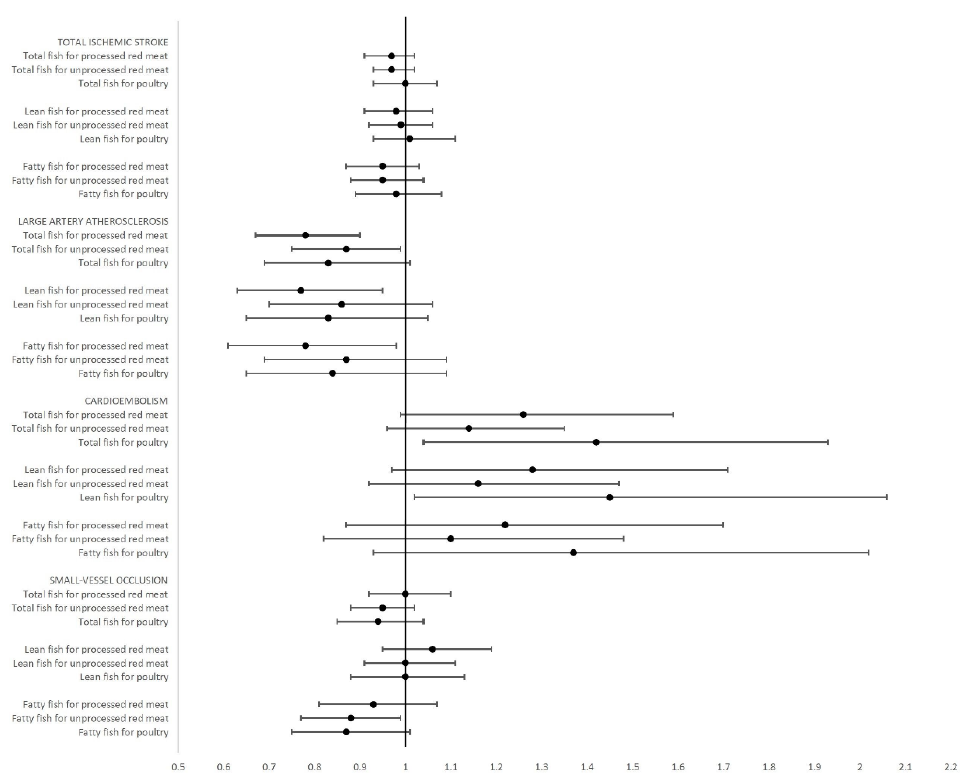
Figure 1. Hazard ratios and 95% confidence intervals for total ischemic stroke, large artery atherosclerosis, cardioembolism, and small-vessel occlusion when substituting total, lean, or fatty fish for processed and unprocessed red meat or poultry. Adjusted for age, sex, energy intake, length of schooling, physical activity, waist circumference adjusted for body mass index, alcohol intake, alcohol abstinence, and smoking status.